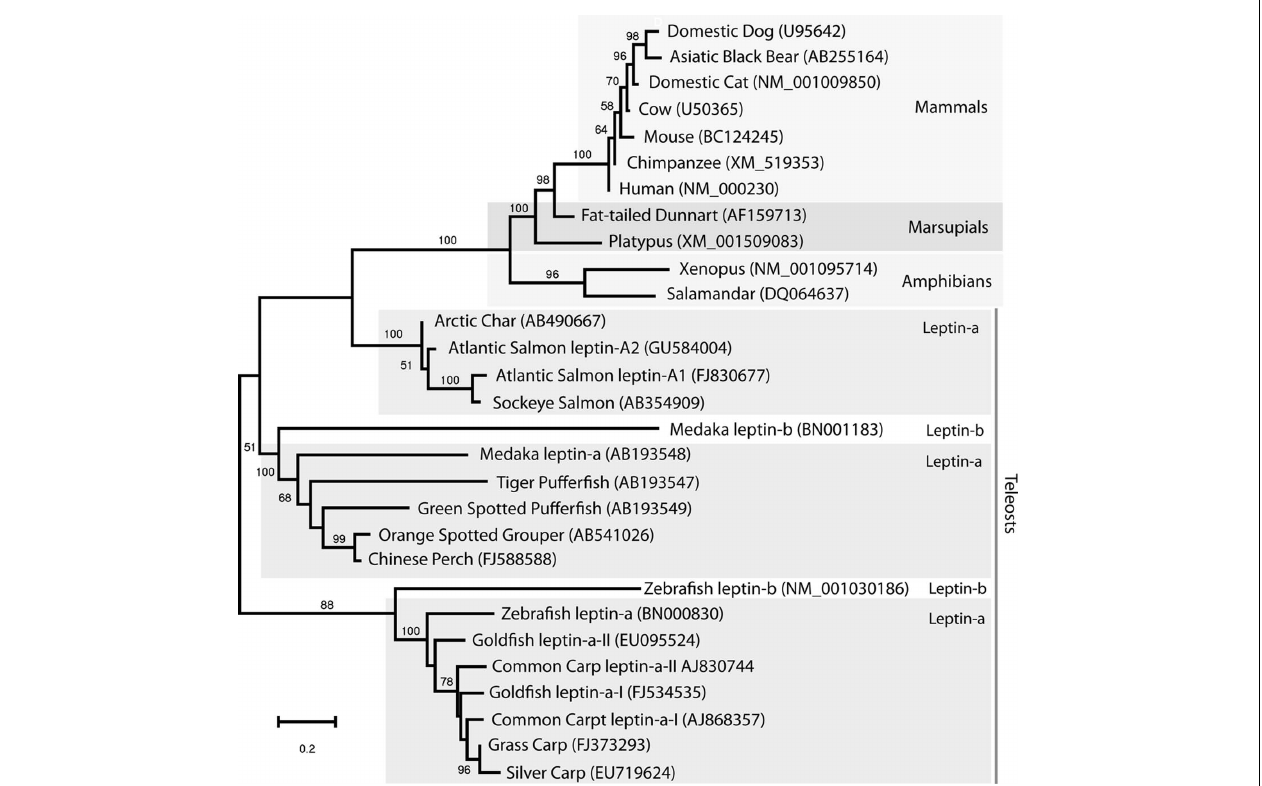
amino acid sequences (excluding duplicate sequences and the 5 (cid:2) to Helix-A) were used for analysis. Numbers at nodes represent support based on 500 bootstrap replications. Lack of bootstrap value indicates less then 50% support at that node. GenBank accession numbers are in parentheses. Leptin paralog names follow those of Gorissen et al.